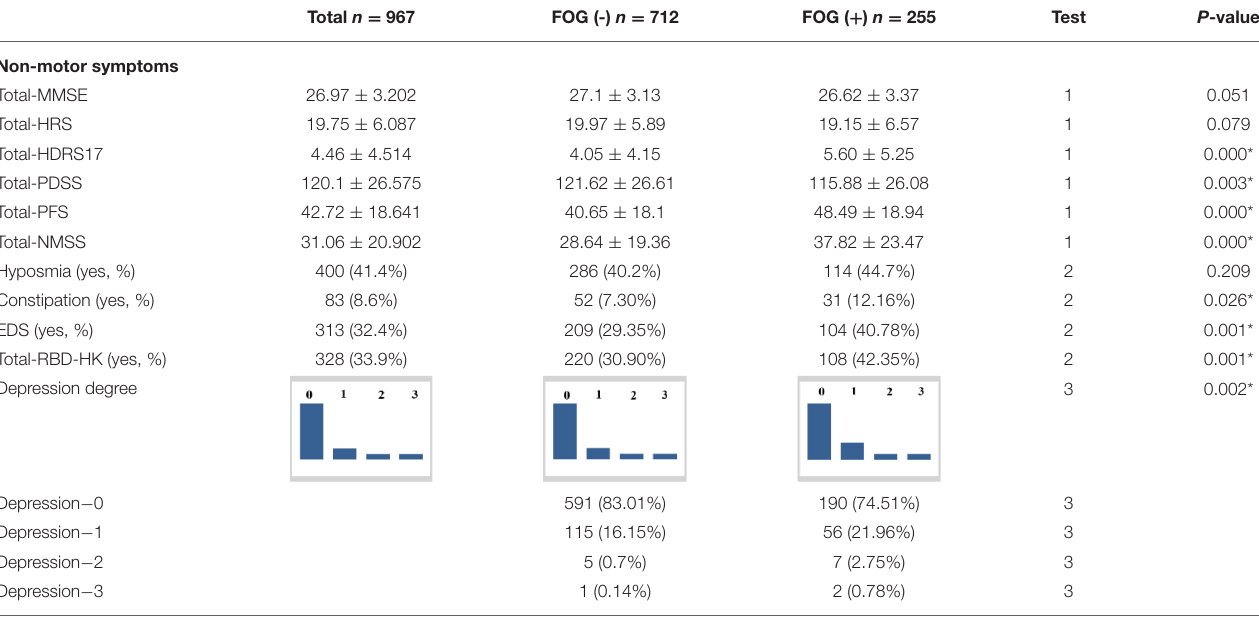
TABLE 3 | Baseline characteristics of non-motor symptoms of the population. Total n = 967 FOG (-) n = 712 FOG ( + ) n = 255 Test P -value